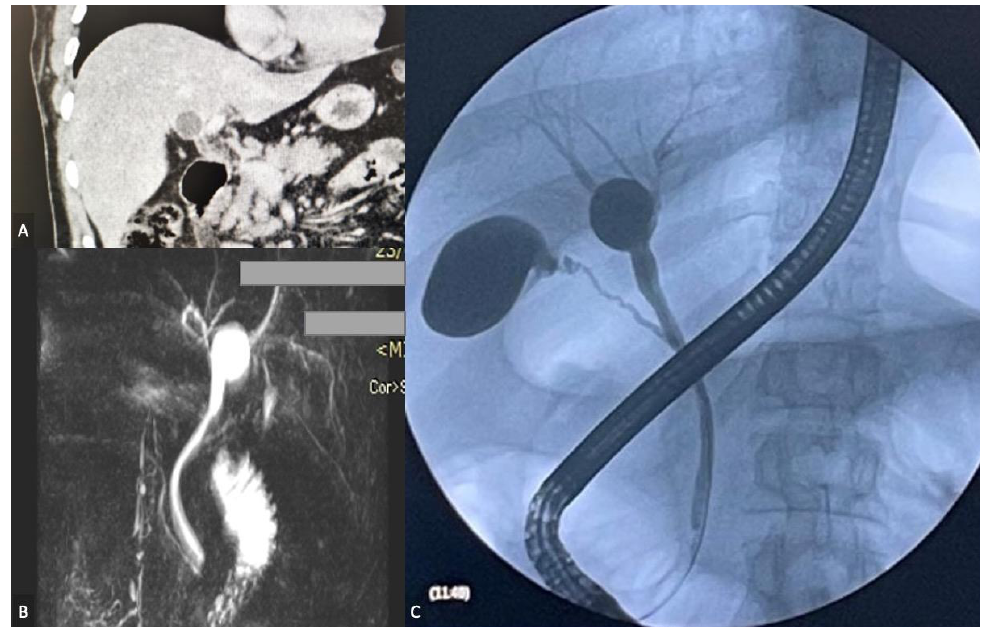
Figure 2. ( A ) CT scan, coronal section — type II CC; ( B ) MRCP reconstruction — type II CC; ( C ) ERCP — fusiform dilatation of the biliary confluence.